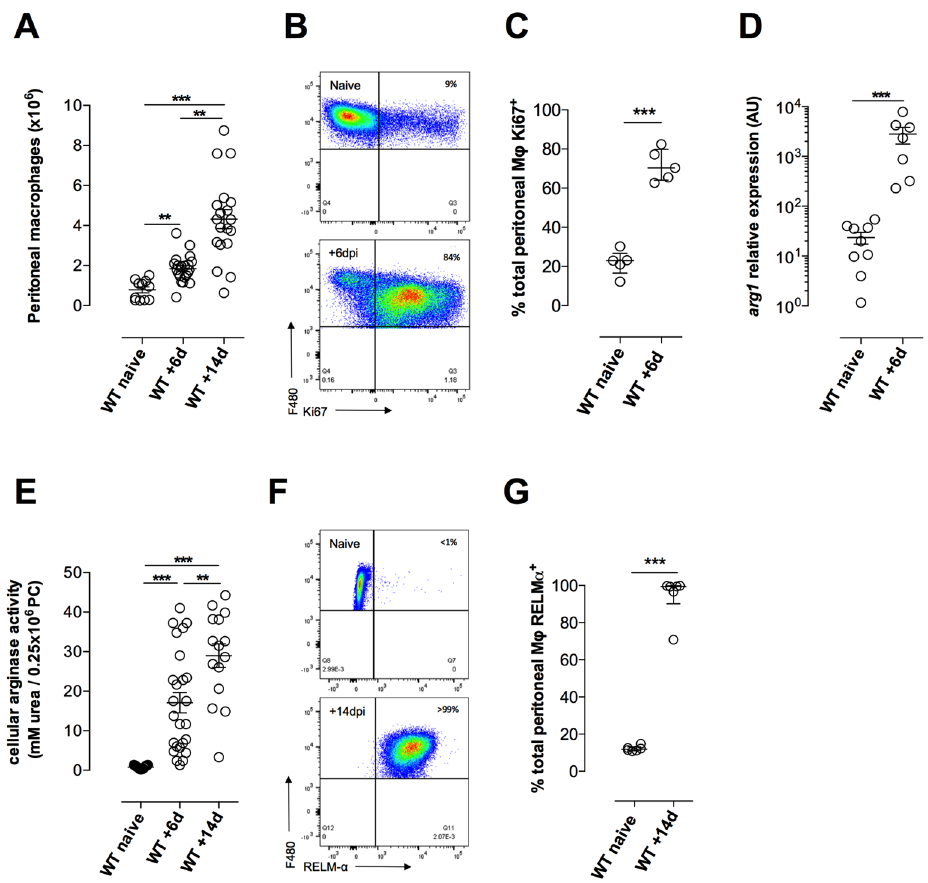
Fig 2. In situ proliferation of macrophages with an alternatively-activated phenotype develop at the site of B . malayi infection. Expansion of F4/80 peritoneal M ϕ (A) , F4/80 peritoneal M ϕ expression levels of Ki67 (B,C) , peritoneal cell (PC) arg1 expression (D) PC arginase activity (E) and F4/80 peritoneal M ϕ expression levels of RELM α (F,G) in WT BALB/c mice at indicated time points post-infection with 50 Bm L3. Data from individual mice with median and interquartile range are plotted. Significant differences between na ï ve or infected WT groups at a given time point is assessed by Mann-Whitney or Kruskal-Wallis + Dunn’s tests ( > 2 groups). Data is plotted is either pooled from 2–3 individual experiments per time-point or from individual experiments with groups of 4–6 mice per group per